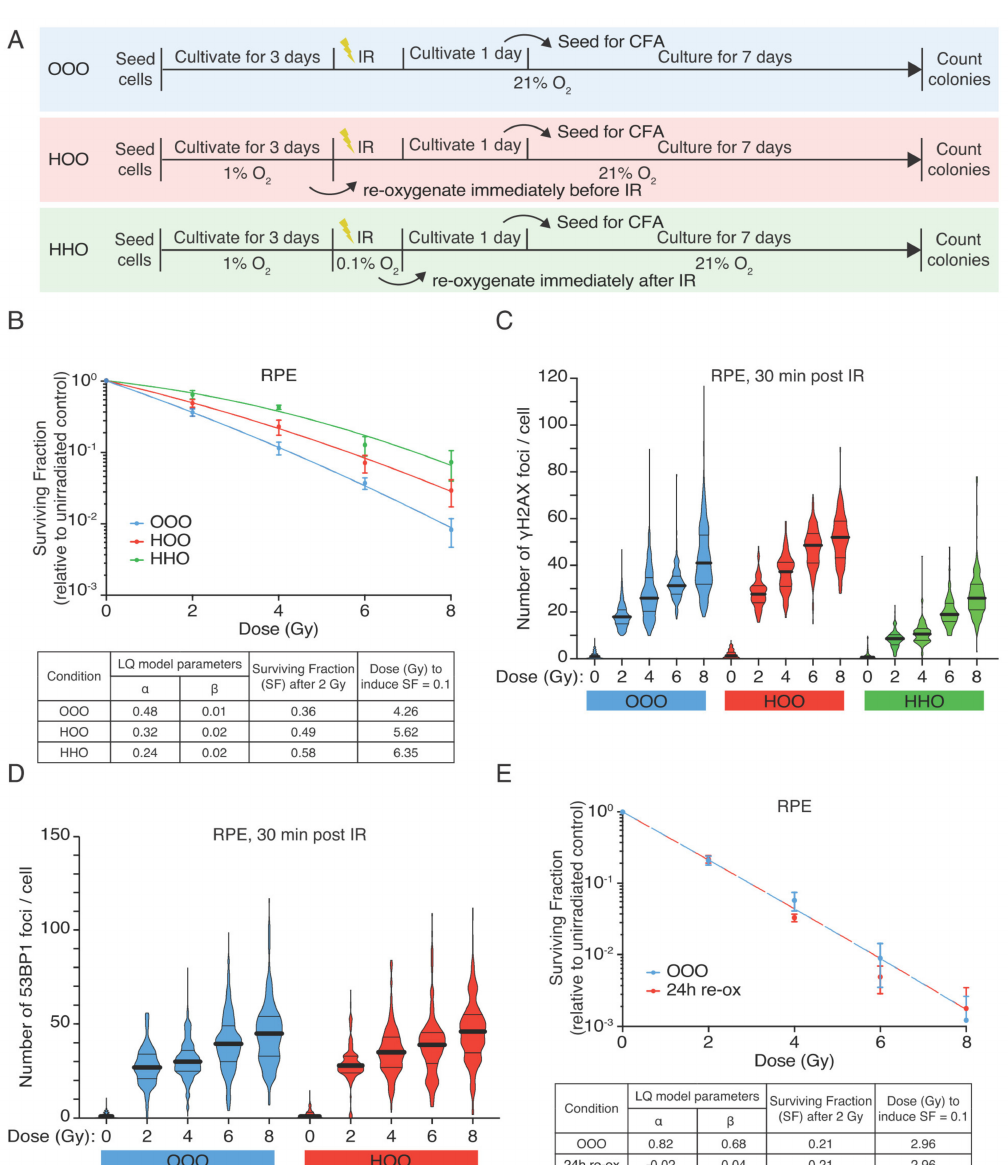
Figure 1. Hypoxic RPE cells retain radioresistant phenotype upon reoxygenation. ( A ) Graphical representation of the experimental design ( B ) Colony-forming assay of RPEcells. RPEcells were irradiated with graded single doses of irradiation after being constantly under normoxic conditions (blue curve—OOO), for 72 h in hypoxia (1% O 2 ) and subsequently irradiated in aerated condition (time of reoxygenation in the range of 15 min) (red curve—HOO) and after 72 h hypoxia and irradiation under hypoxic conditions (0.1% O 2 —green curve HHO) before been reoxygenated immediately after IR. The data points represent the means of three independent experiments, and the error bars the 95% C.I. of the means estimation. The data were fitted with linear quadratic model, the parameters of the Linear Quadratic model (LQ) of the RPE survival curves are shown collectively for all conditions in a separate table. ( C ) DNA DSBs measured as γ H2AX foci in RPEcells 30 min after irradiation with graded single doses of irradiation under normoxic (OOO, blue violin plots) and hypoxic conditions either kept in 1% O 2 for 72 h and reoxygenated just prior to irradiation (HOO, red violin plots) or also irradiated under hypoxia (0.01% O 2 ) (HHO, green violin plots). ( D ) 53BP1 foci in RPE cells 30 min post-irradiation (two of the conditions as referred in ( B ). Black solid lines represent the population mean and the dotted lines the quartiles of the data distribution ( E ) Colony-forming assay of RPE-1 cells that have been kept under hypoxic conditions (1% O 2 ) for 72 h, before being reoxygenated for 24 h and then irradiated under normoxic conditions. Data represent the pool of three independent experiments, and the error bars the 95% C.I. of the means estimation. The parameters of the LQ model are depicted in a separated